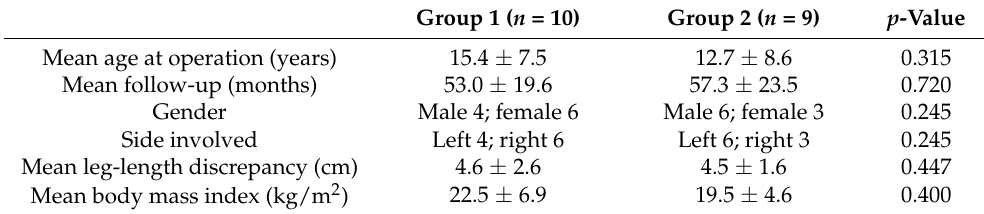
Table 1. Demographic features of the included patients.